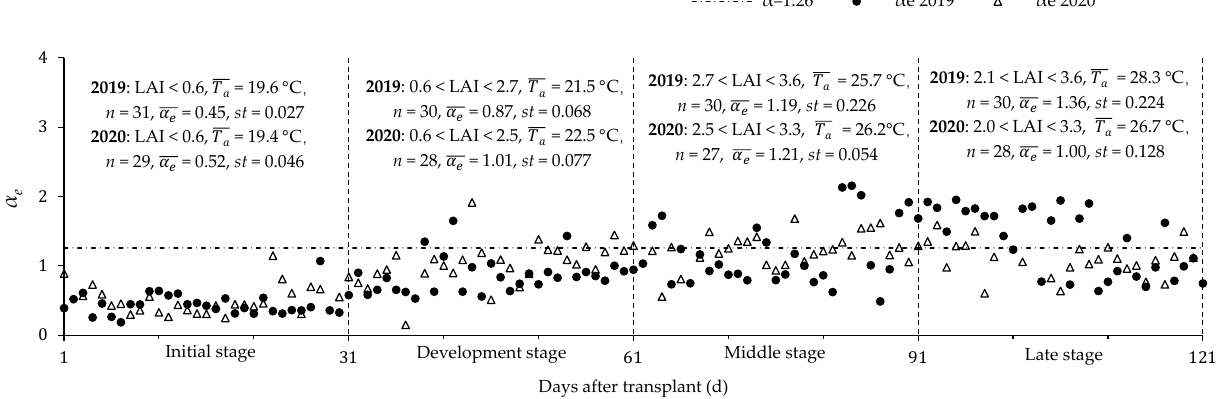
Figure 6. Variations of improved Priestley – Taylor coefficient ( α e ) during the whole growth stage in 2019 and 2020. LAI is the leaf area index, T a is the mean air temperature, α e is the mean of α e , st is the variance of α e .